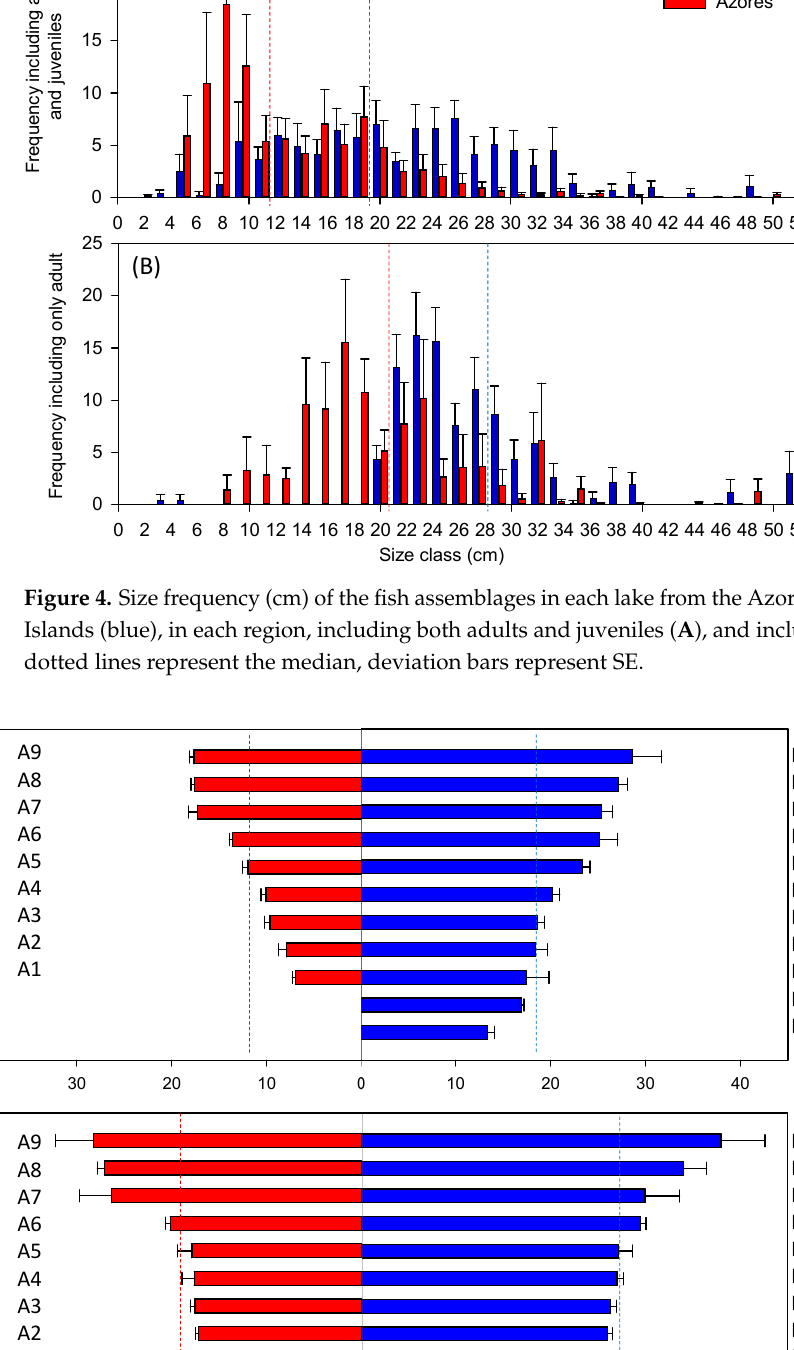
Table 3. Fish potential predation pressure indicators, showing mean ± SE values in the two cli- matic regions and the results of statistical tests (in this case Student t -tests).